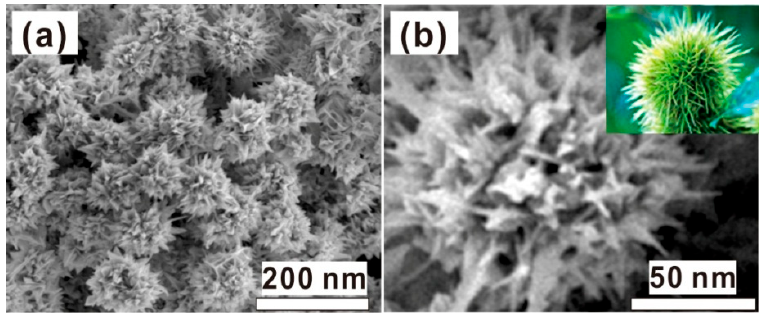
Figure 2. The field emission scanning electron microscope (FESEM) images of the as-prepared products. ( a ) The image with low magnification. ( b ) The magnified image of the single particle in ( a ). The inset is the photo of one chestnut for reference.